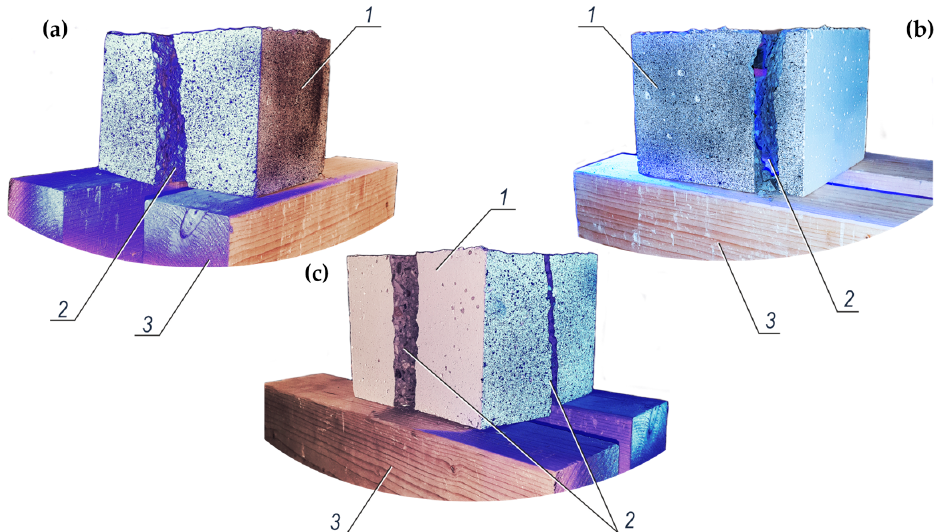
Figure 13. Images of typical failure of concrete specimens after pulling out the ribbed rebars of 16 mm in diameter: ( a ) uniform breaking of the specimen into two parts, ( b ) inclined breaking of the specimen into two parts, ( c ) breaking of the specimen into four parts; 1 —concrete specimen with the pulled-out reinforcement, 2 —cracked location in the specimen, 3 —wooden beams supporting the concrete specimens after pulling out the rebar.